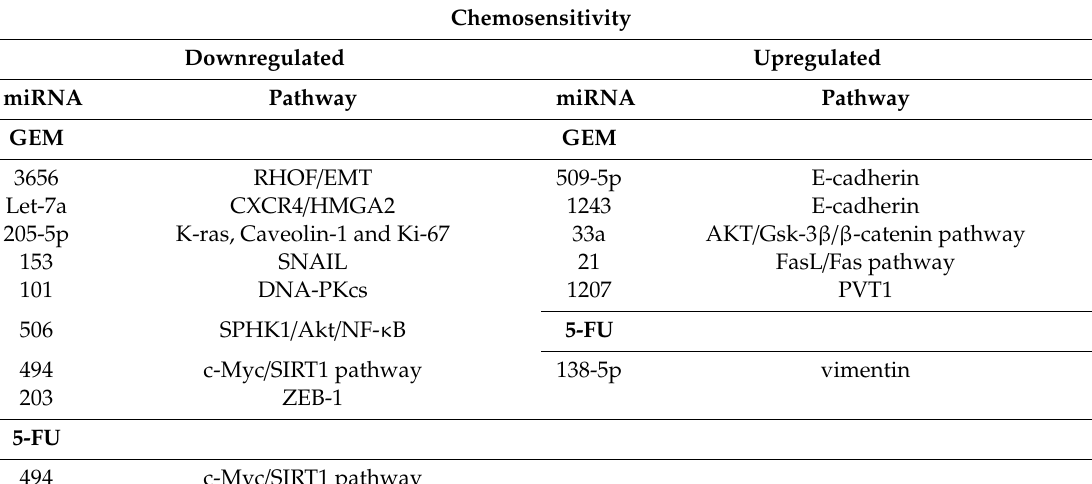
Table 3. miRNAs that are involved in chemosensitivity and pathways that are